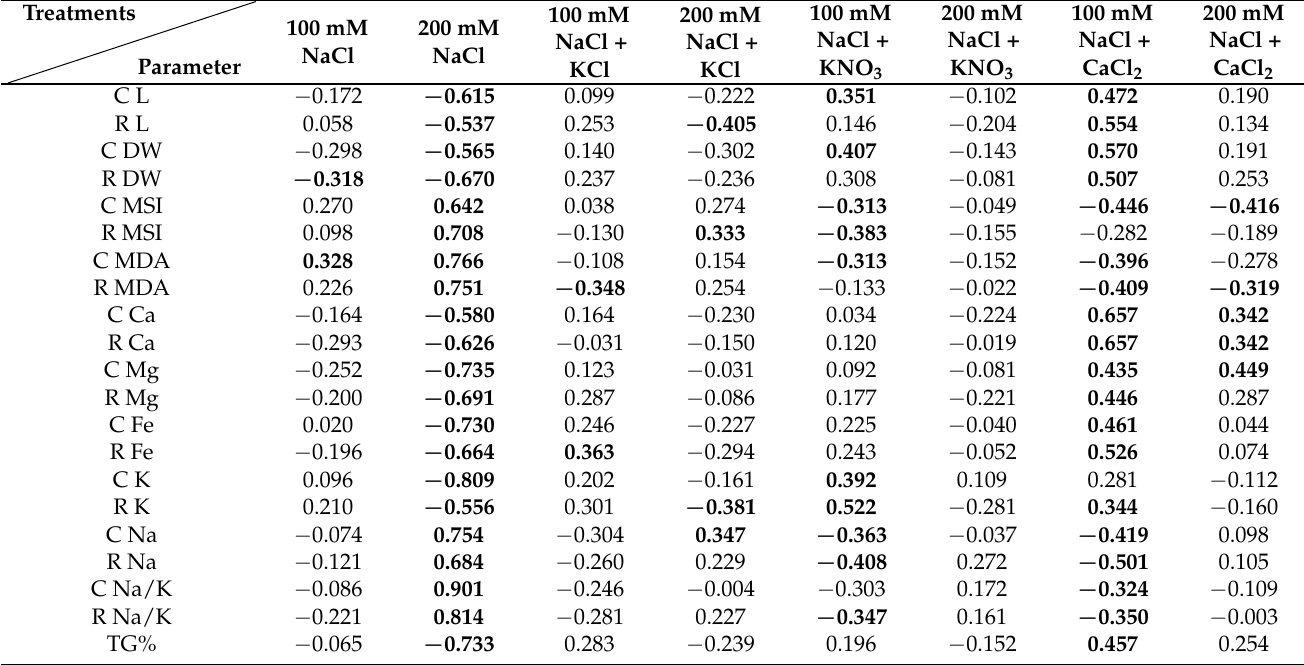
Table 3. Hordeum vulgare (L. Manel) Pearson’s correlation matrix: C L: coleoptile length; R L: radicle length; C DW: coleoptile dry weight; R DW: radicle dry weight; C MSI: coleoptile membrane stability index; R MSI: radicle membrane stability index; C MDA: coleoptile malondialdehyde content; R MDA: radicle malondialdehyde content; C Ca: coleoptile calcium content; R Ca: radicle calcium content; C Mg: coleoptile magnesium content; R Mg: radicle magnesium content; C